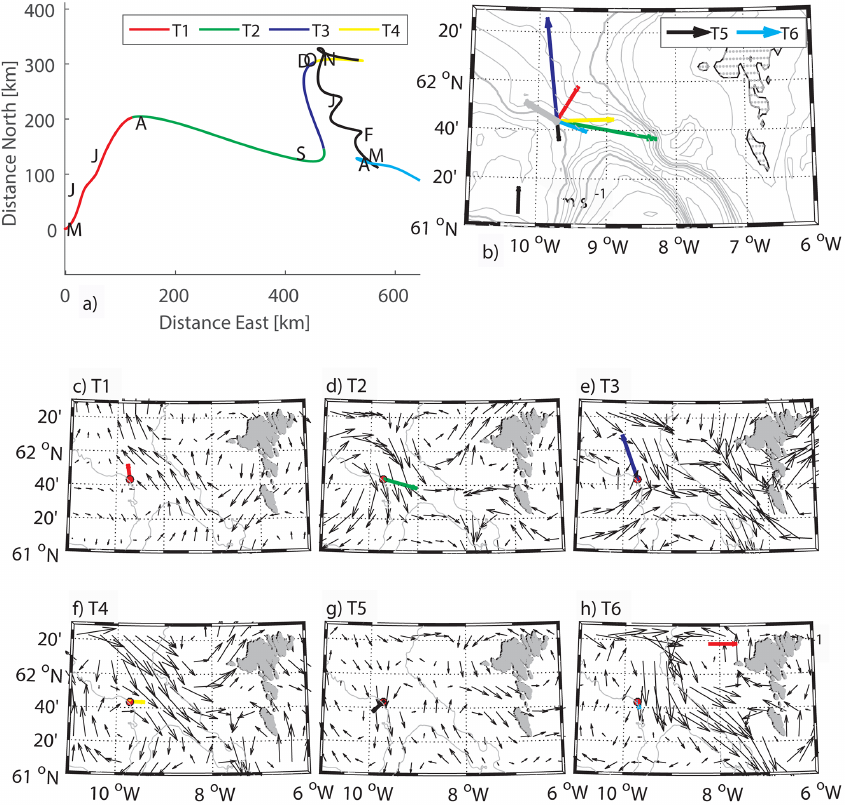
Figure 8. (a) Progressive vector diagram of upper layer velocity ( u up ) from S3 with data from time intervals T 1 –T 6 (Table 2) coloured according to the legend. (b) Mean velocity in the upper layer at S3 during T 1 –T 6 . The velocity scale is given in the lower left corner and the grey arrow at S3 shows the mean direction of the dense plume, 75mab. Data in (a–b) are vertical mean values from 150 to 500m depth. Mean geostrophic velocity anomaly (AVISO) during (c) T 1 , (d) T 2 , (e) T 3 , (f) T 4 , (g) T 5 and (h) T 6 . The mean upper layer velocity anomaly from S3 for each period is included for reference and the velocity scale (for c–h ) is given in the lower right corner of (h) as a labelled red line. The location of S3 is marked with a red circle in (c–h)